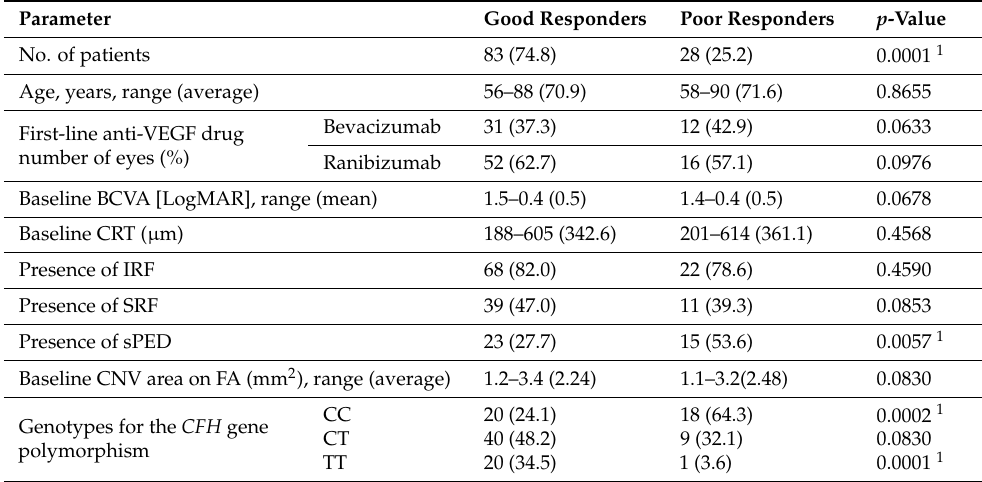
Table 5. Baseline characteristics of patients with age-related macular degeneration (AMD) according to response to anti-VEGF therapy.